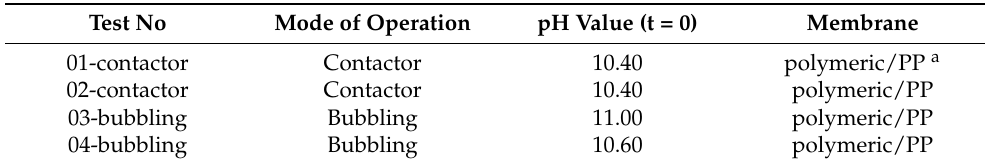
Table 2. Experimental operating parameters of test